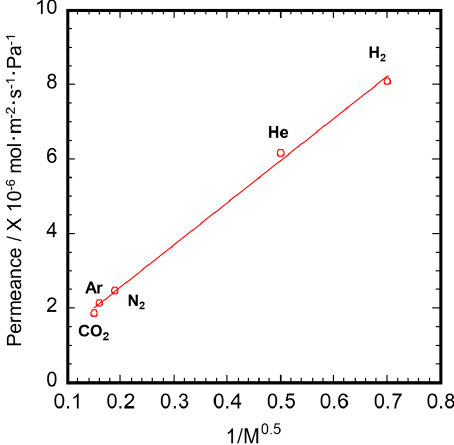
/ α -Al 2 O 3 porous capillary.